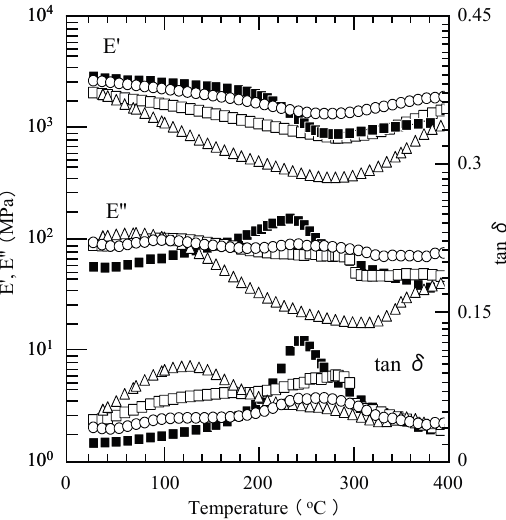
Figure 12. Viscoelastic properties of cured films of PP-4va ( ■ ), and P(P-4va/BuA) with 33 ( ○ ), 50 ( □ ), and 58 ( ∆ ) mol % of BuA composition.